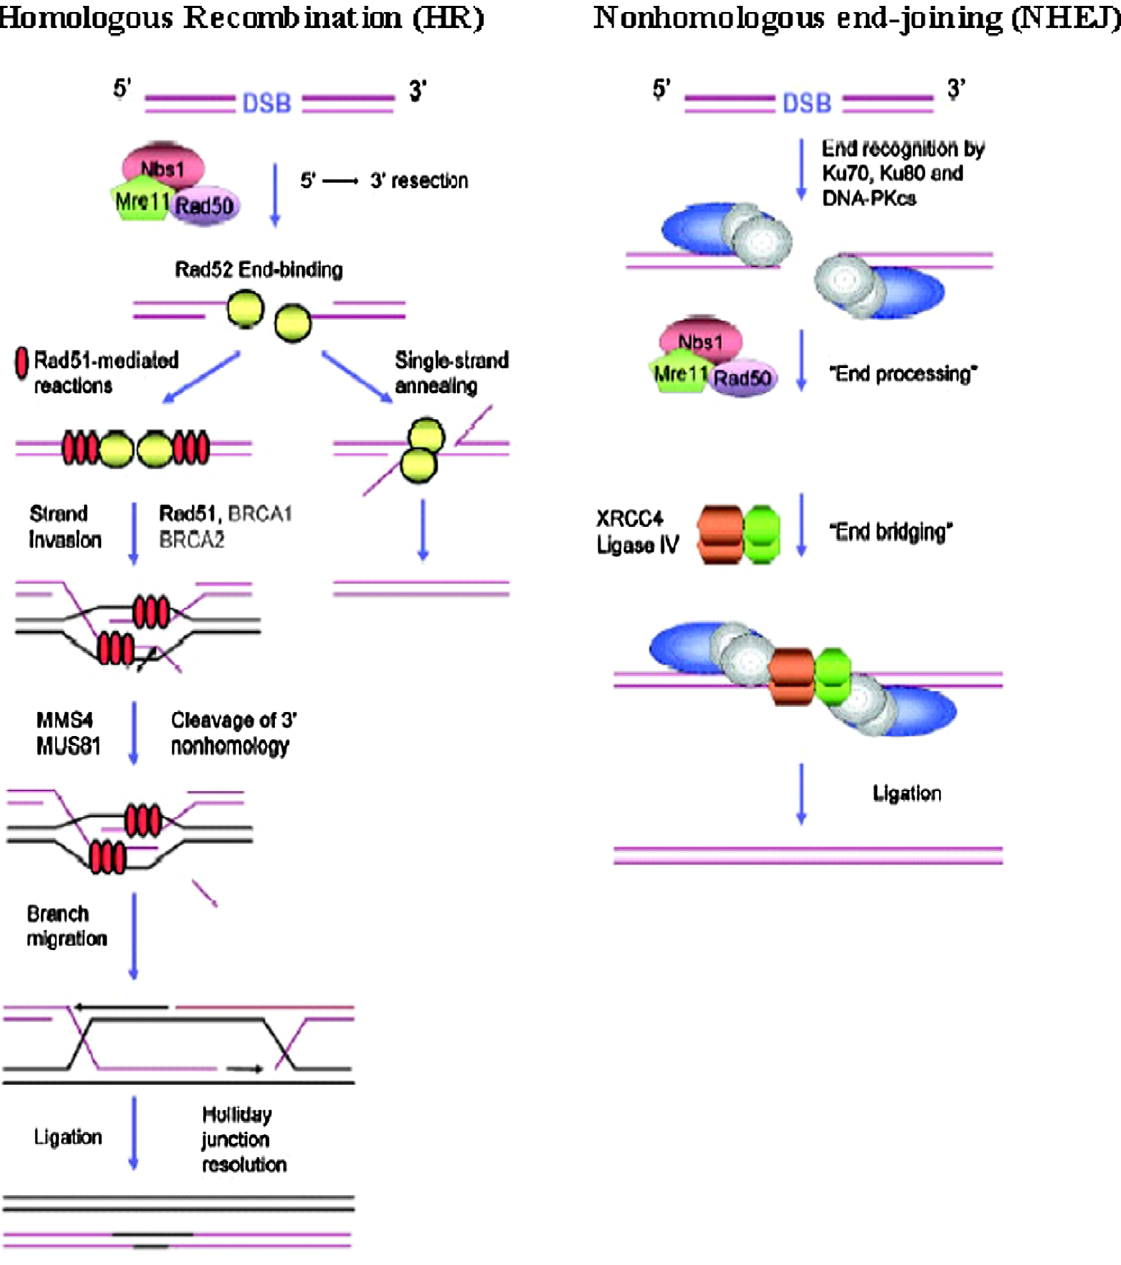
Fig. 5. Schematic representation the homologous recombination (HR), single-stand annealing (SSA) and non-homologous end joining (NHEJ) repair pathways (Figure reprinted, with permission, from the Annual Review of Biochemistry , Volume 73 c (cid:2) 2004 (Sancar et al.) [125] by Annual Reviews